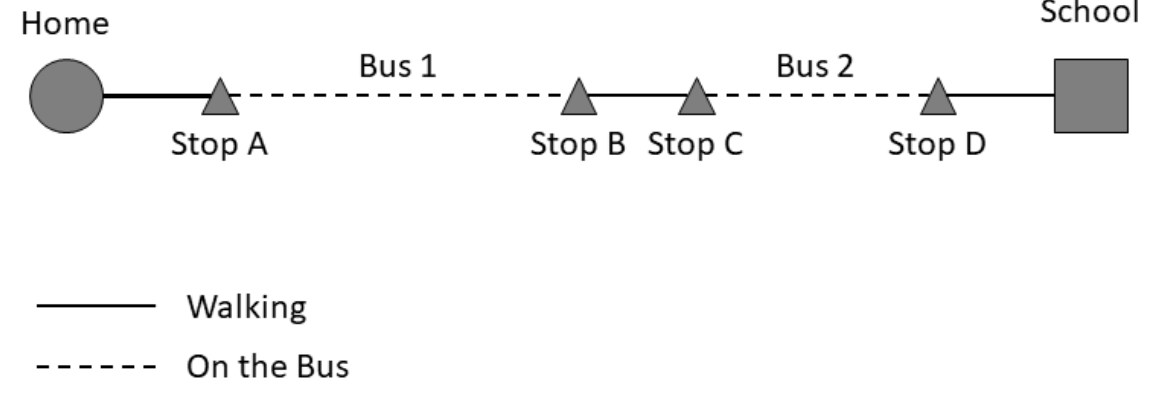
Figure 1: Example trip to school via public transportation. Figure 3 takes the distribution of crimes at transit stops across the city, smoothed using the kernel density function in ArcGIS, and overlays the estimated number of students who pass through that stop each day on their way to school. Student